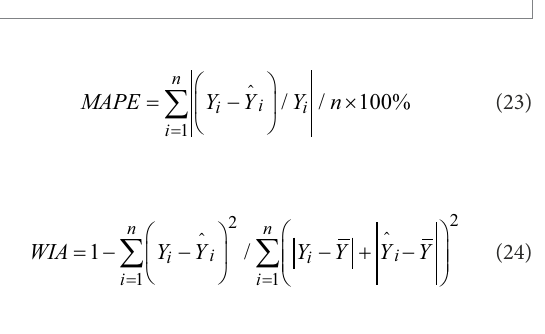
FIGURE 5 Decomposition results of “Ningbo Attraction” SED after TVF-EMD algorithm.